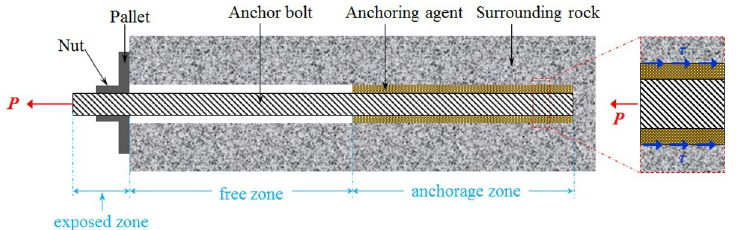
Fig 1. Force transfer mechanism in an anchor